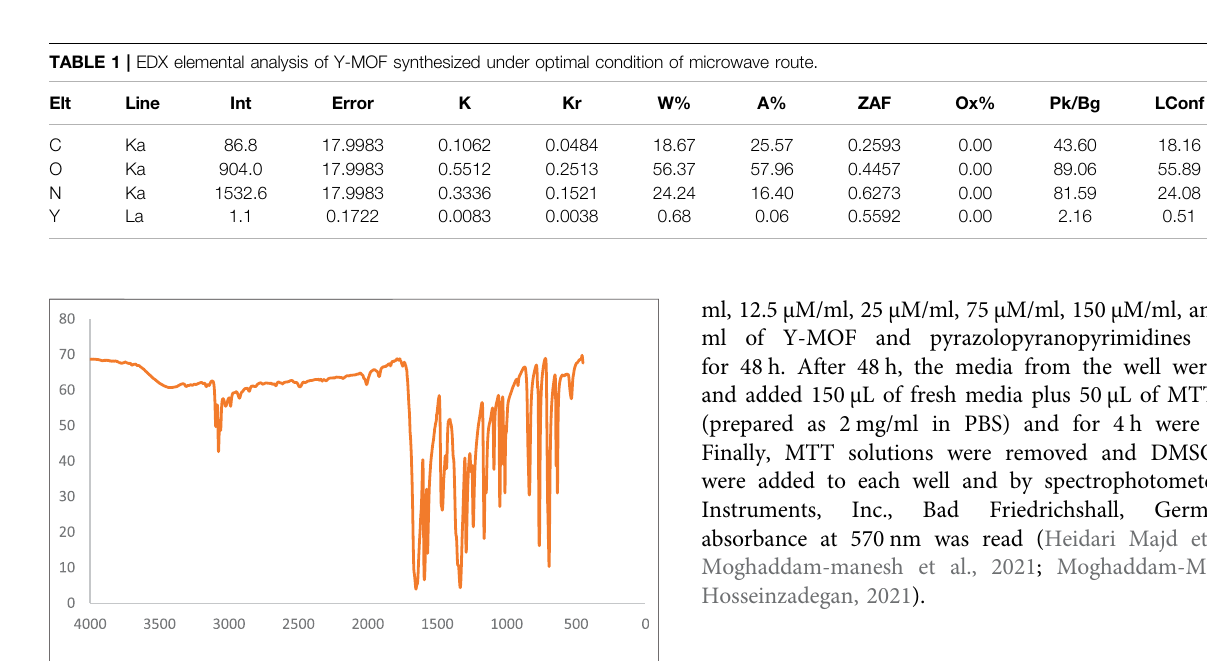
FIGURE 5 | FTIR spectrum of Y-MOF synthesized under the optimal condition of the microwave route.